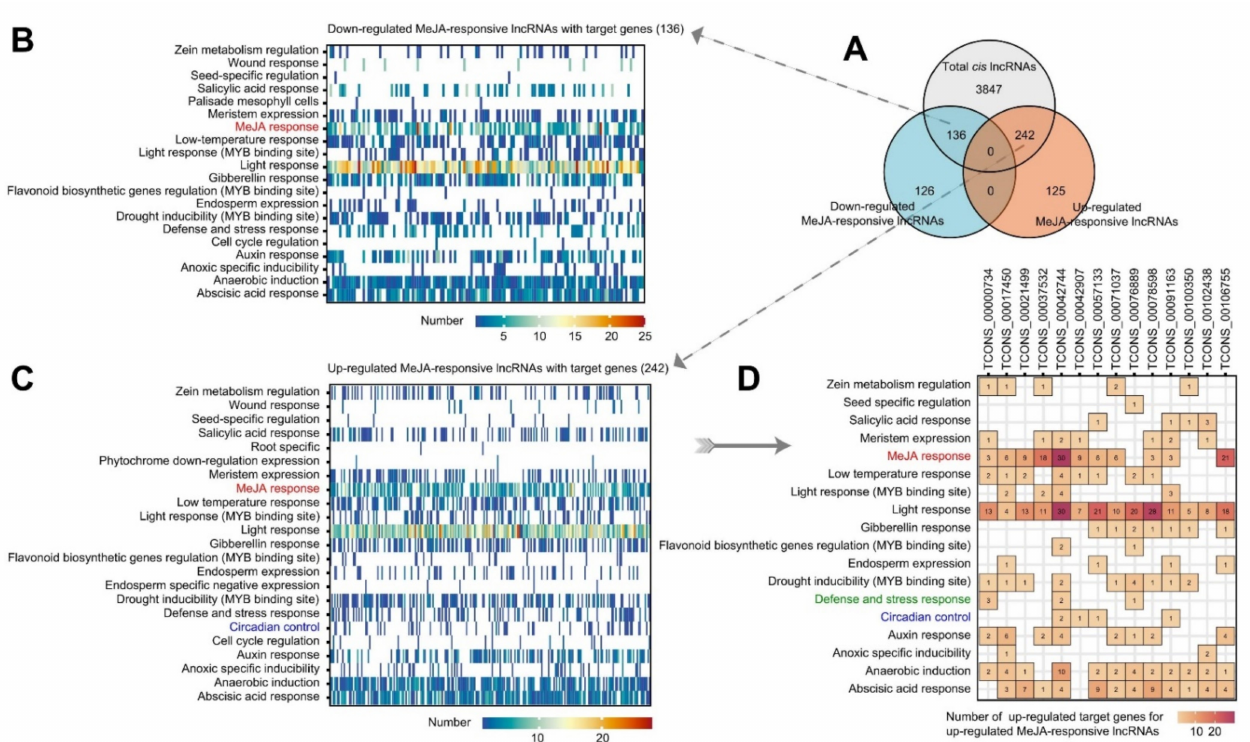
Figure 6. Cis -acting element patterns of up- or downregulated MeJA-responsive lncRNAs with cis -target genes. ( A ) Numbers of up- and downregulated cis -regulated MeJA-responsive lncRNAs. ( B , C ) Status of cis -acting elements that are present upstream of down- and upregulated MeJA- responsive IncRNAs with target genes. ( D ) Detailed cis -acting elements of upregulated MeJA- responsive lncRNAs having upregulated target genes associated with a stimulus-response (Figure